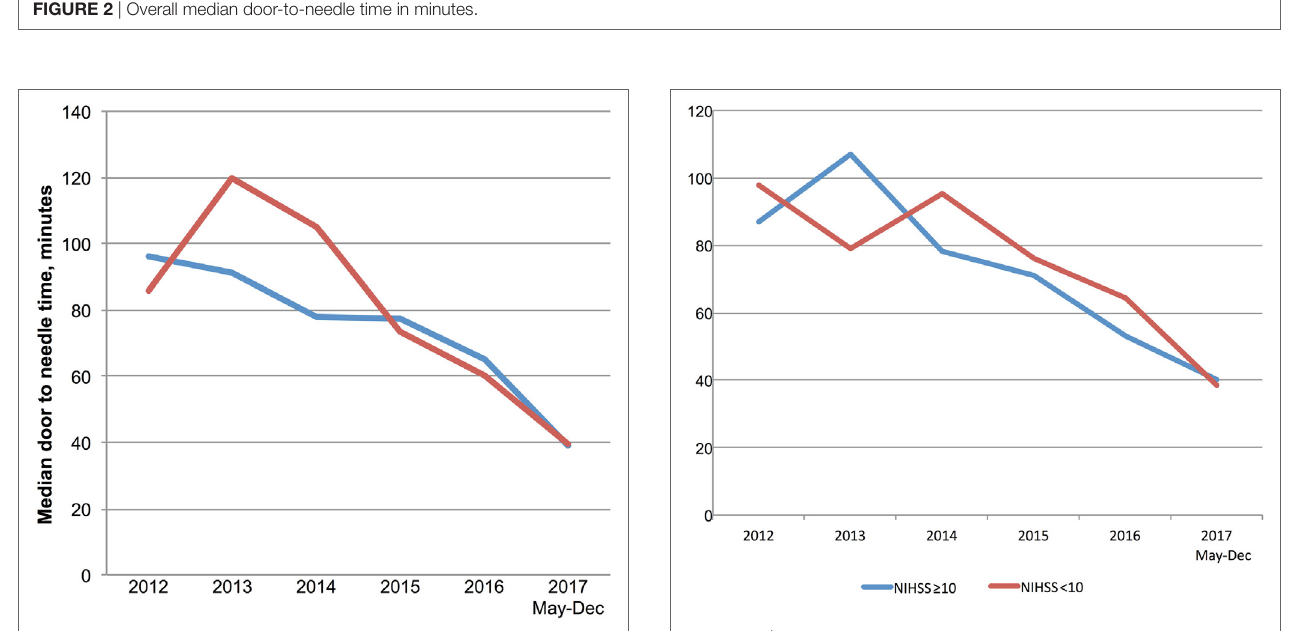
FigUre 2 | Overall median door-to-needle time in